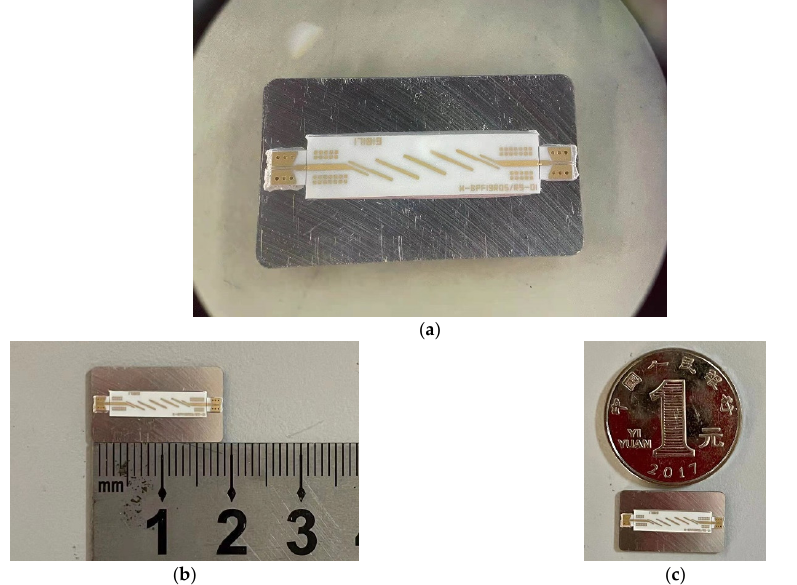
Figure 6. The picture of: ( a ) entire filter model; ( b ) detail size of the filter with ruler; ( c ) detail size with coin with the radius of 25 mm.